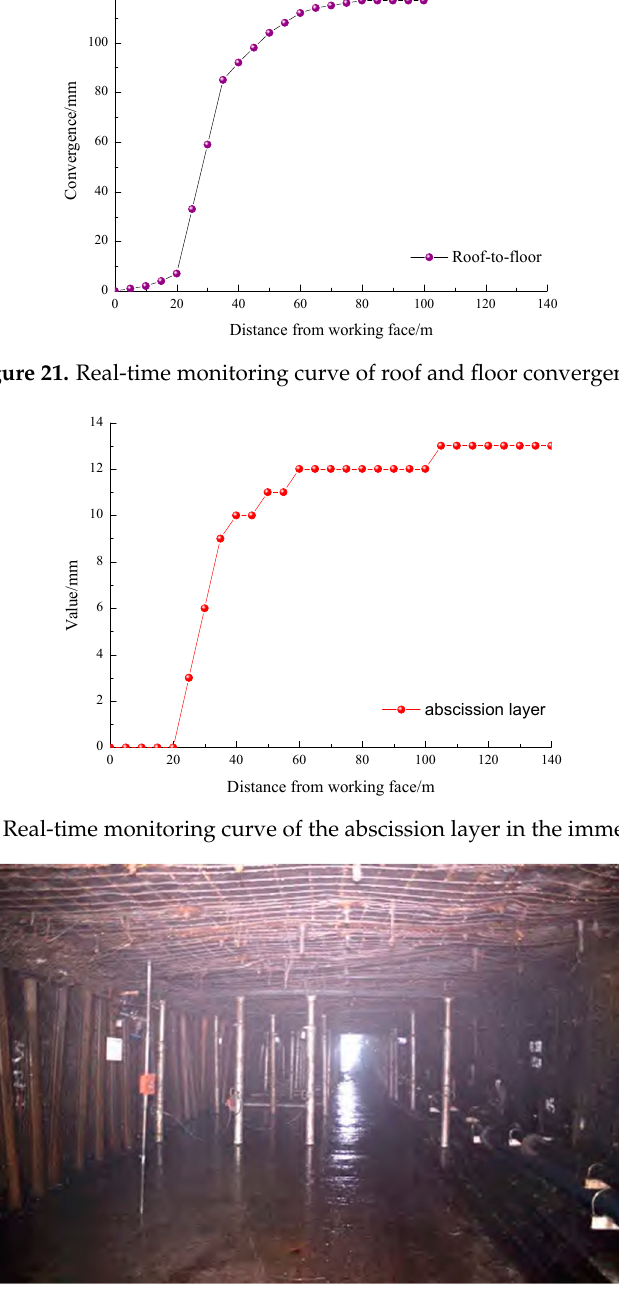
Figure 23. Effect of the formed roadway after removing the hydraulic support and the π -beam.